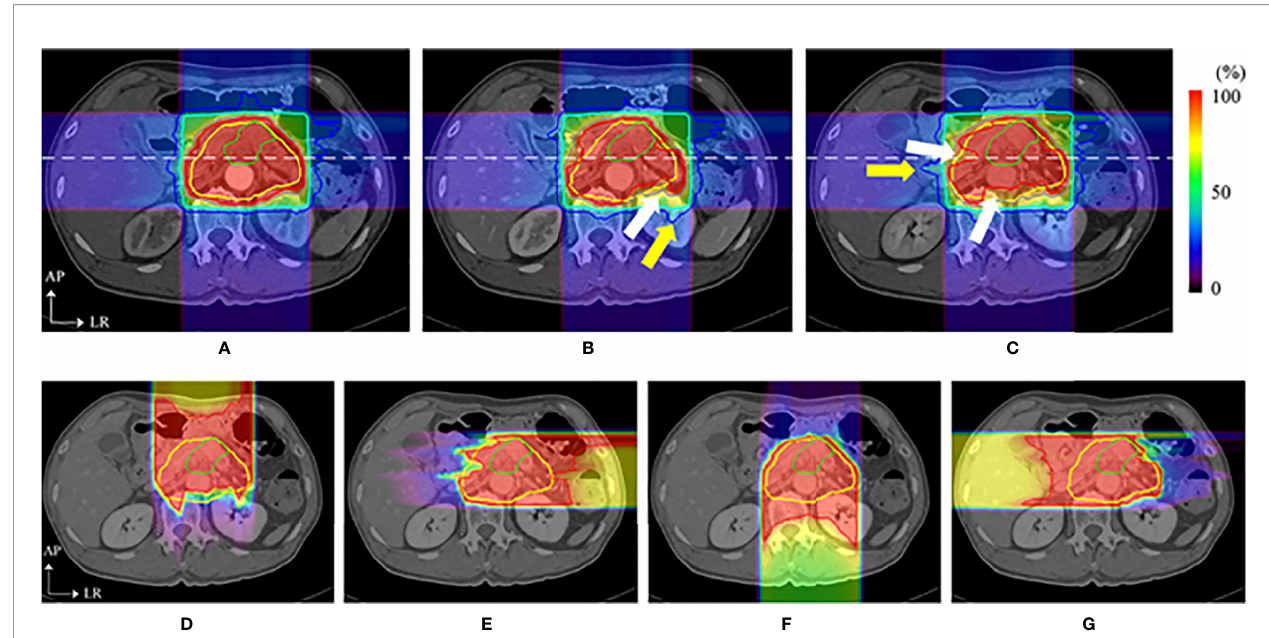
FIGURE 5 | Dose distributions of a carbon ion RT in axial sections. The top images show the dose distribution of planning CT (A) , the dose distribution with a delay time of (B) 35 s (intra-CT), and (C) 145 s (intra-CT), respectively. Beam overshoot (yellow arrows) and undershoot (white arrows) were observed at scan intervals of 35 and 145 s. The bottom images show the dose distributions of (D) 0°, (E) 90°, (F) 180°, and (G) 270° at 145 s. The green and yellow lines show the shapes of the gross tumor volume and the clinical target volume, respectively. The rainbow contours show the dose distribution (35) (Source: Elsevier. Used with